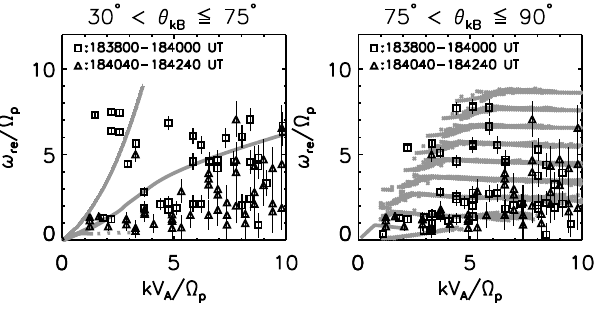
Figure 4. Distribution of the wave frequencies in the plasma rest frame and the wavevector magnitudes for the local peaks of the four-dimensional energy spectra for different groups of wavevector angles from the mean magnetic field. Left panel, top to bottom: dis- persion relations from the linear Vlasov theory are shown in gray for the whistler, kinetic slow, and the ion cyclotron modes for ion beta β i = 0 . 3 and the median wavevector angle θ kB = 50 ◦ ; right panel: the ion Bernstein modes (at harmonics of the ion gyrofrequency) and kinetic Alfvén mode (at the lowest frequencies) at the angle θ kB = 85 ◦